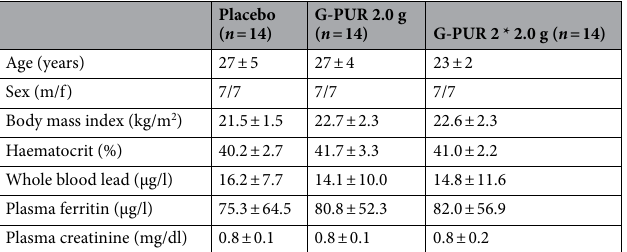
Table 1. Subject characteristics by treatment group at baseline. Absolute numbers and means ± SD are indicated.